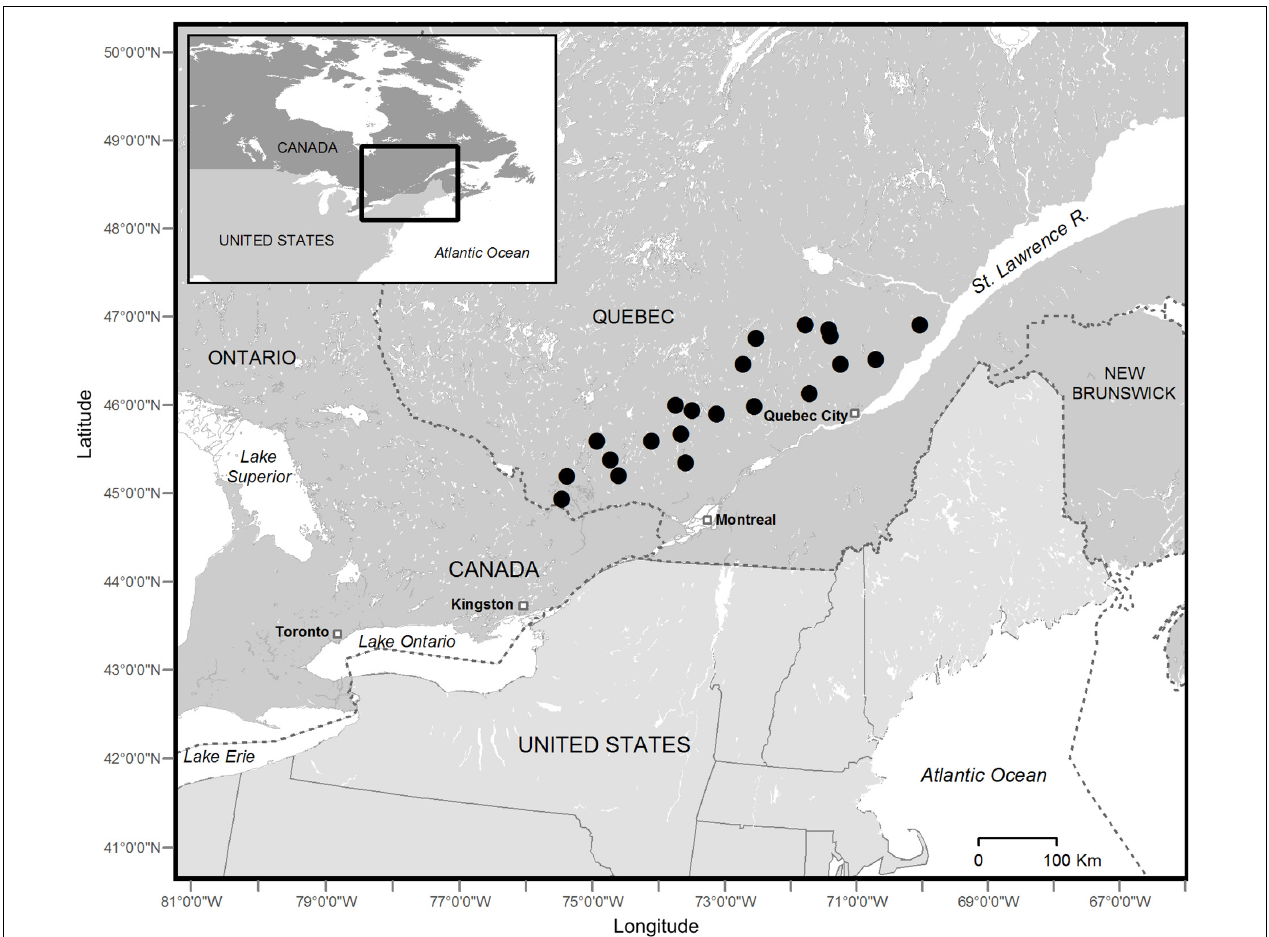
FIGURE 1 | Location of the study